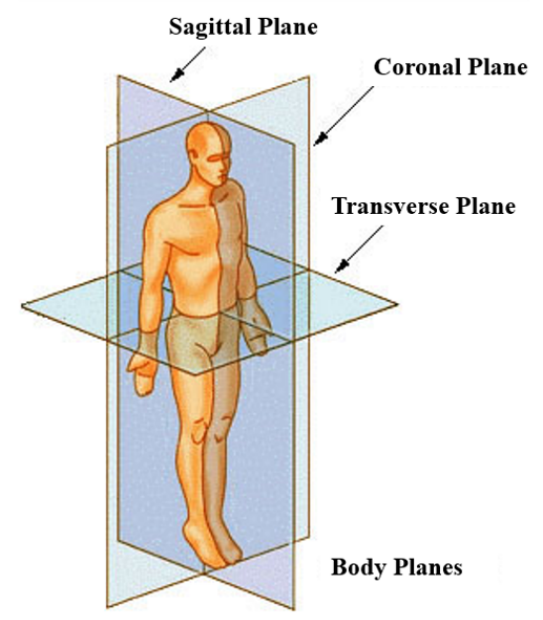
Figure 4. Determination of the CBoM [60].